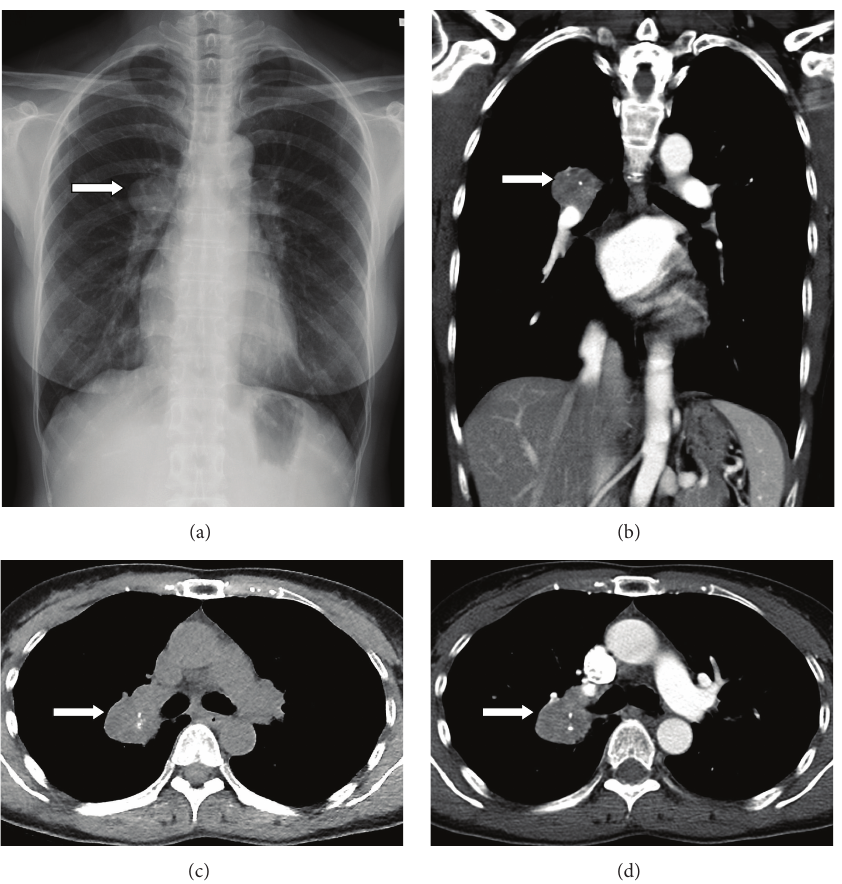
Figure1:(a)ChestX-raystudydetectsamass(whitearrow)intherightpulmonaryhilarregion.(c)PrecontrastCTscanrevealsawell-defined right hilar mass with flecks of calcification and some low attenuation area. ((b) and (d)) Contrast enhanced CT scan shows a heterogeneous enhanced mass in the right pulmonary hilar